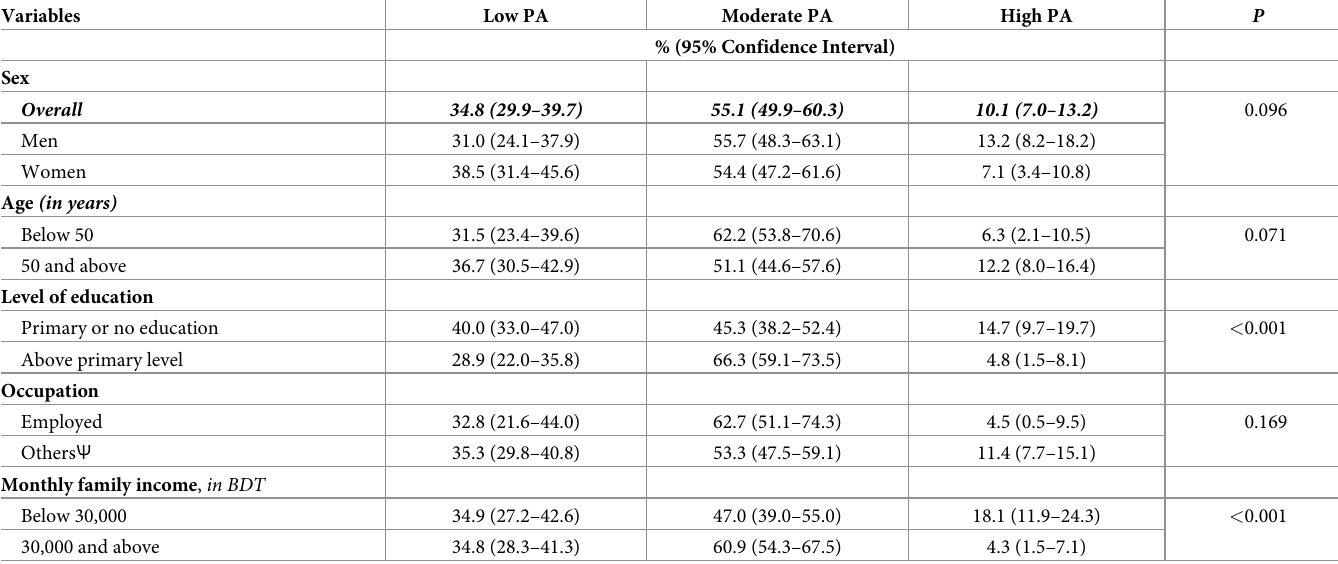
Table 2. Prevalence of low, moderate, and high physical activity levels by sociodemographic characteristics ( n =